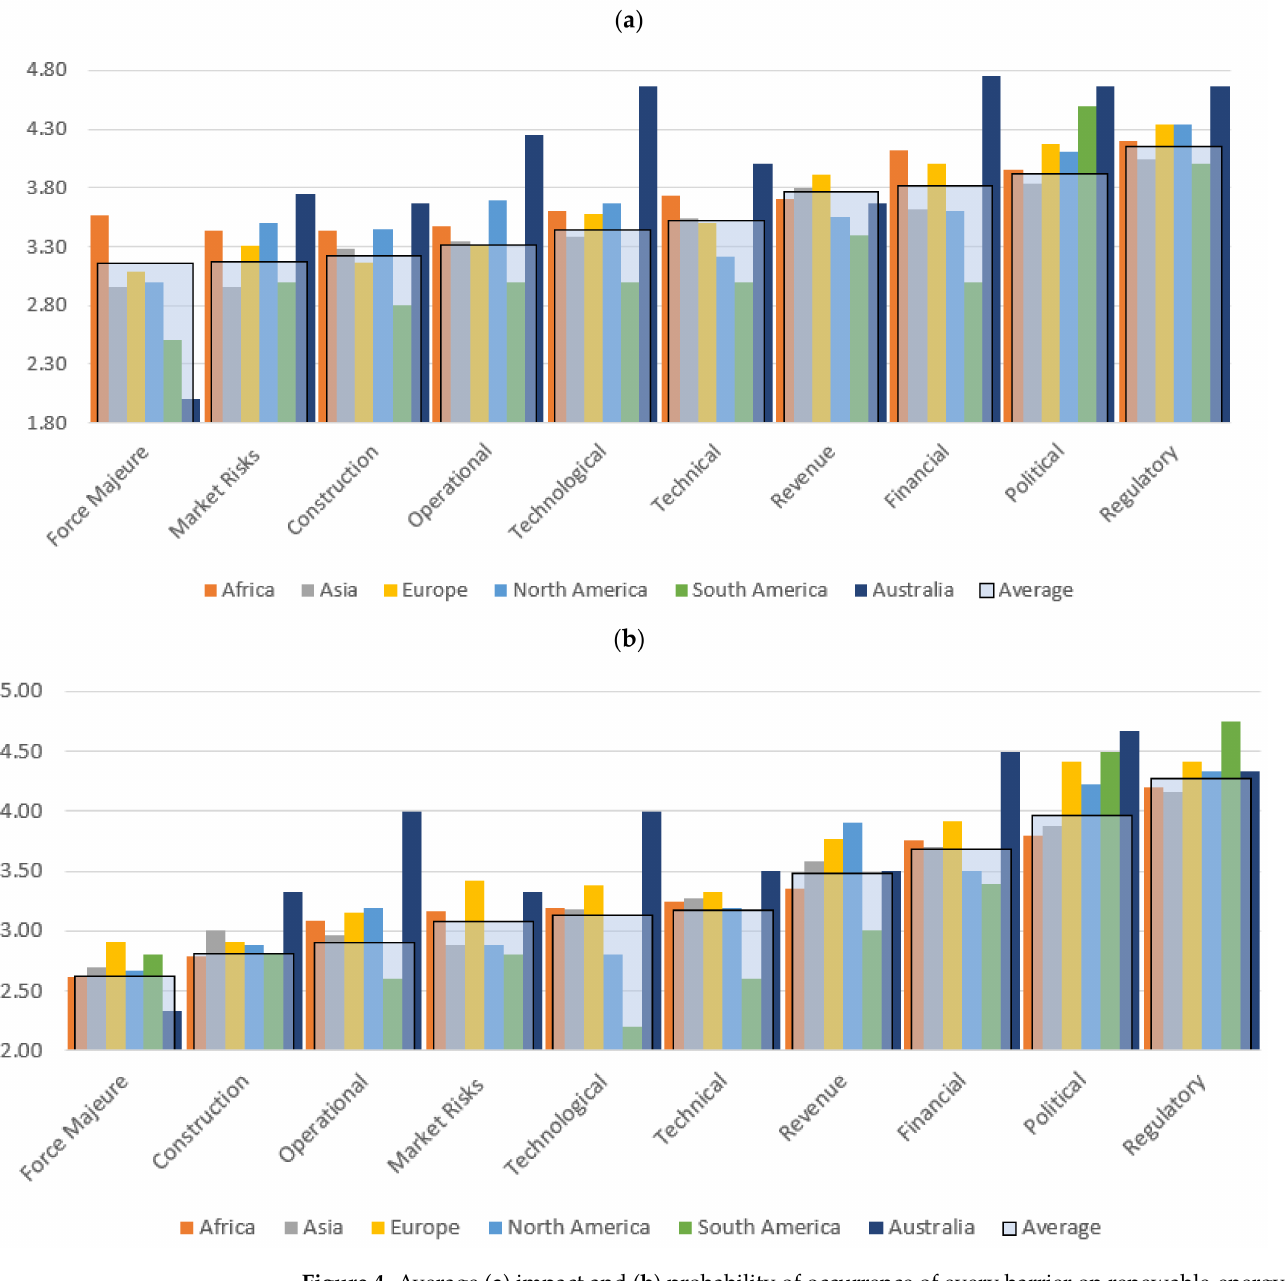
Figure 4. Average ( a ) impact and ( b ) probability of occurrence of every barrier on renewable-energy PPPs across the